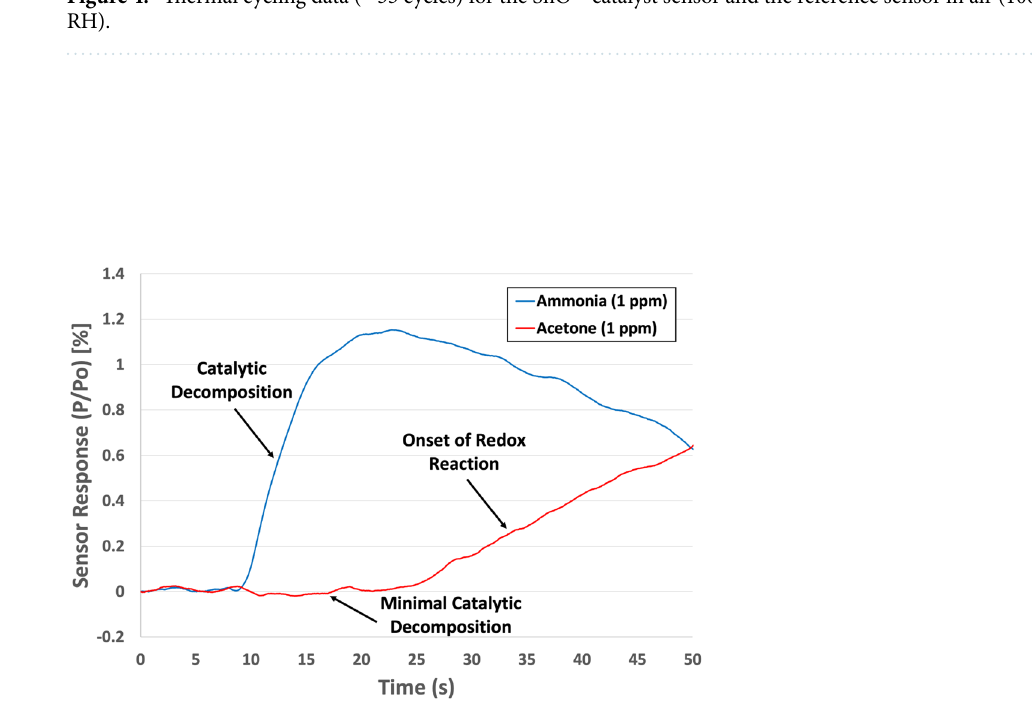
Figure 5. Responses of a thermodynamic sensor to 1 ppm ammonia and 1 ppm